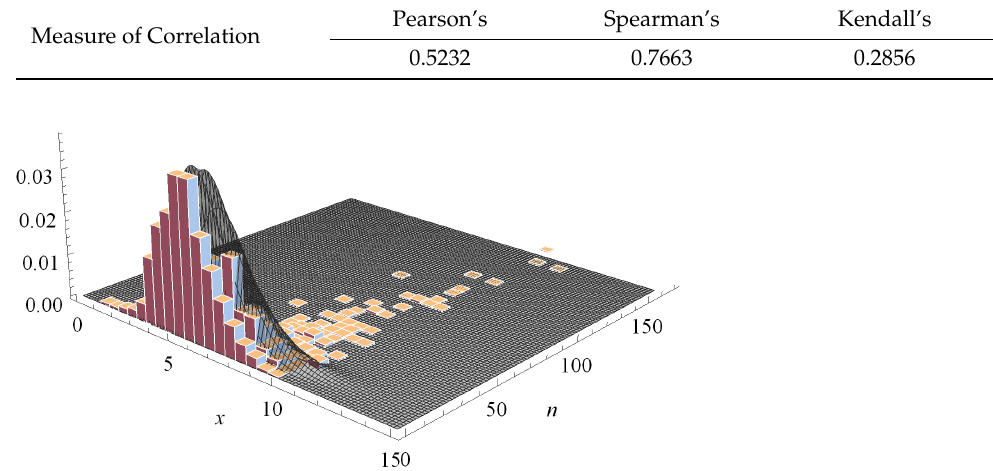
Table 2. Pearson’s, Spearman’s and Kendall’s measures of correlation for the two dependent variables considered.